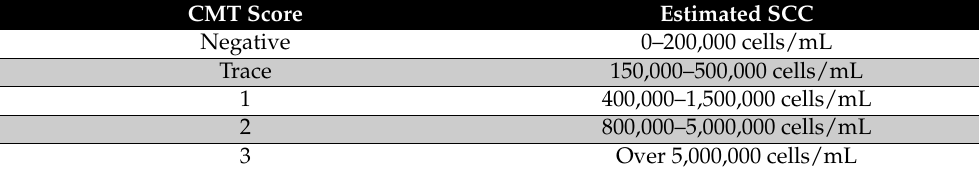
Table 1. Interpretation of CMT